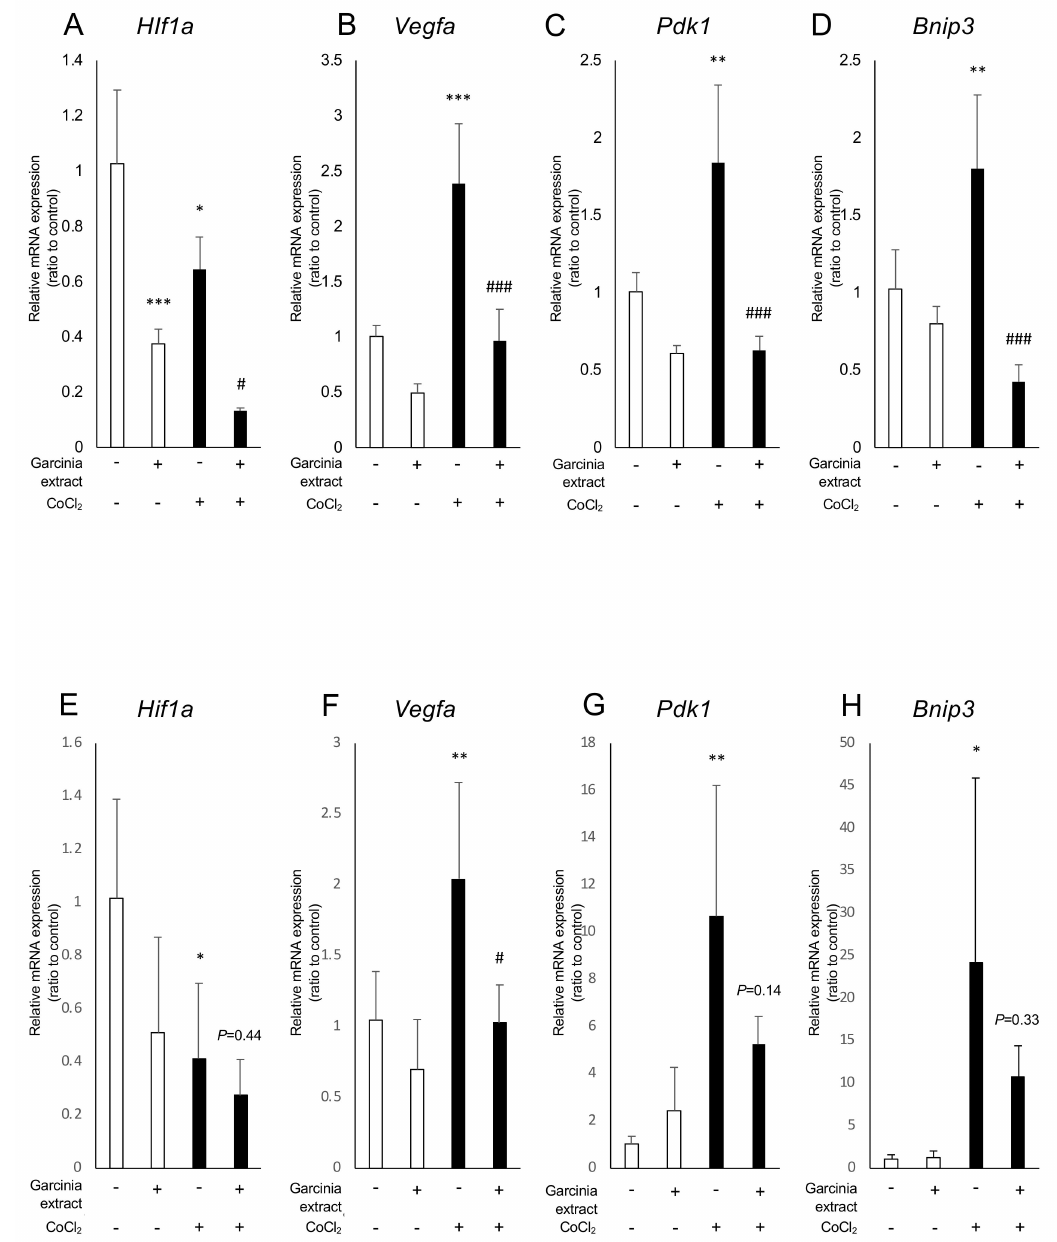
Figure 2. Hif1 α and the downstream genes were downregulated by Garcinia extract administration. ( A ) Hif1a was downregulated by Garcinia extract administration with or without CoCl 2 in APRE19 cells. The downstream genes of HIFs, including ( B ) Vegfa , ( C ) Pdk1 , and ( D ) Bnip3 were significantly downregulated by the administration of Garcinia extract in ARPE19 cells. ( E ) Hif1a was downregulated by Garcinia extract administration in 661W cells significantly without CoCl 2 . ( F ) Vegfa was significantly downregulated by the administration of Garcinia extract in 661W cells. ( G ) Pdk1 and ( H ) Bnip3 also showed a similar tendency. * p < 0.05, ** p < 0.01, *** p < 0.001 compared with the control. # p < 0.05, = ### p < 0.001 compared with CoCl 2 without chetomin and Garcinia extract, n